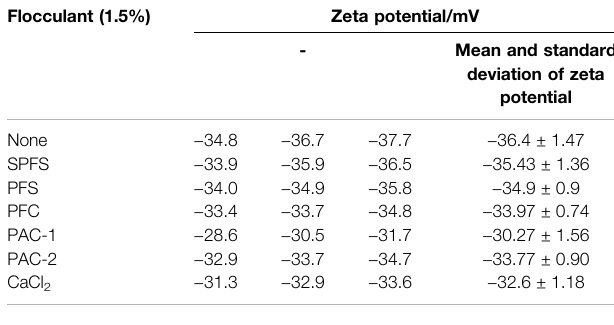
TABLE 3 | In fl uence of the inorganic fl occulant on the zeta potential and particle size distribution in Biodrill-A drilling fl uid. Flocculant (1.5%)